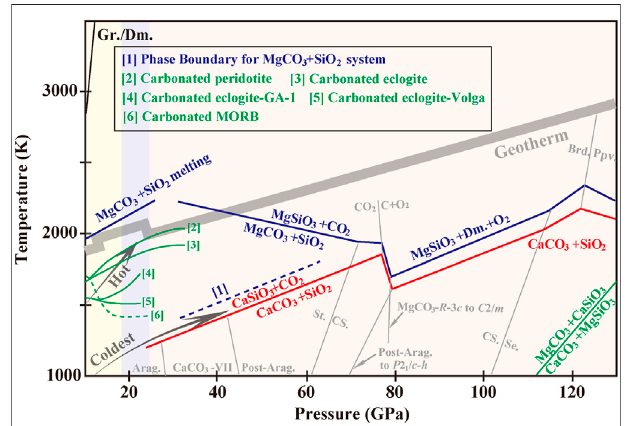
FIGURE 3 | Schematic reaction line of carbonate-silicate at the Earth ’ s mantle conditions. The black lines representing CaCO 3 -SiO 2 reaction is measured according to Li et al. (2018) and Zhang and Liu (2015). The dark- blue lines indicate phase boundaries for MgCO 3 -SiO 2 system (solid: Maedaet al., 2017;dotted [1]: Takafuji et al.,2006). Partial melting ofMgCO 3 - SiO 2 series produces a simple eutectic system (Kakizawa et al., 2015). Curve [2] represents solidus curve of carbonated peridotite (Litasov and Ohtani, 2009).SoliduscurvesofcarbonatedeclogitesareplottedaccordingtoLitasov and Ohtani (2010) (Curve [3]) and Kiseeva et al. (2013) (Curve [4], [5]). The melting curve of carbonated MORB (Curve [6]) according to Thomson et al. (2016). Phase diagram for the stability of MgCO 3 +CaSiO 3 versus CaCO 3 +MgSiO 3 is referred to Santos et al. (2019). Phase boundaries of CaCO 3 - and MgCO 3 -polymorphs follow the references in Section 2.1 . The phase diagrams of SiO 2 (Murakami et al., 2003; Grocholski et al., 2013), CO 2 (Litasovet al., 2011)and MgSiO 3 (Komabayashi etal., 2008)areincludedwith gray solid lines. Abbreviations: Gr., graphite; Dm., diamond; St.,